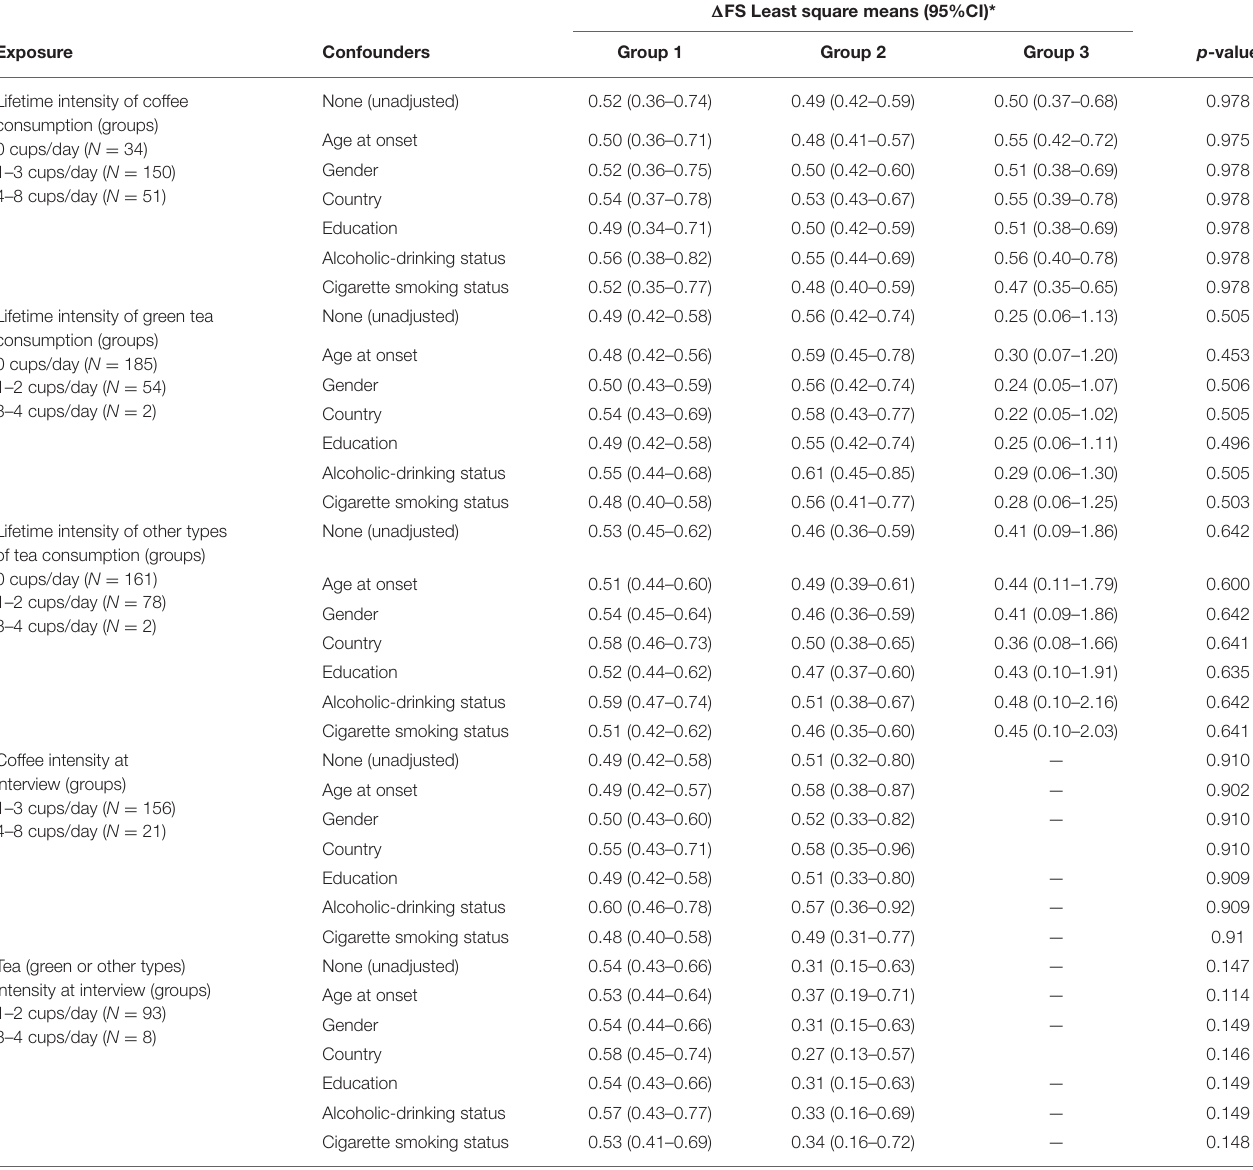
TABLE 5 | Association between the intensity of coffee and tea consumption on 1 FS, unadjusted and adjusted least-square means from ANOVA models using 1 FS log-transformed